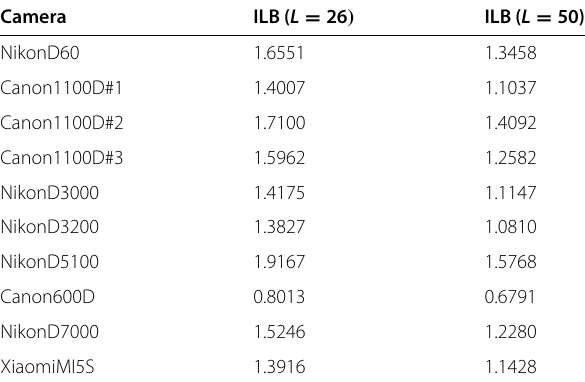
Table 1 Lower bound (6) in bits per pixel for different cameras and sizes of estimation sets when the wavelet-based denoising filter is